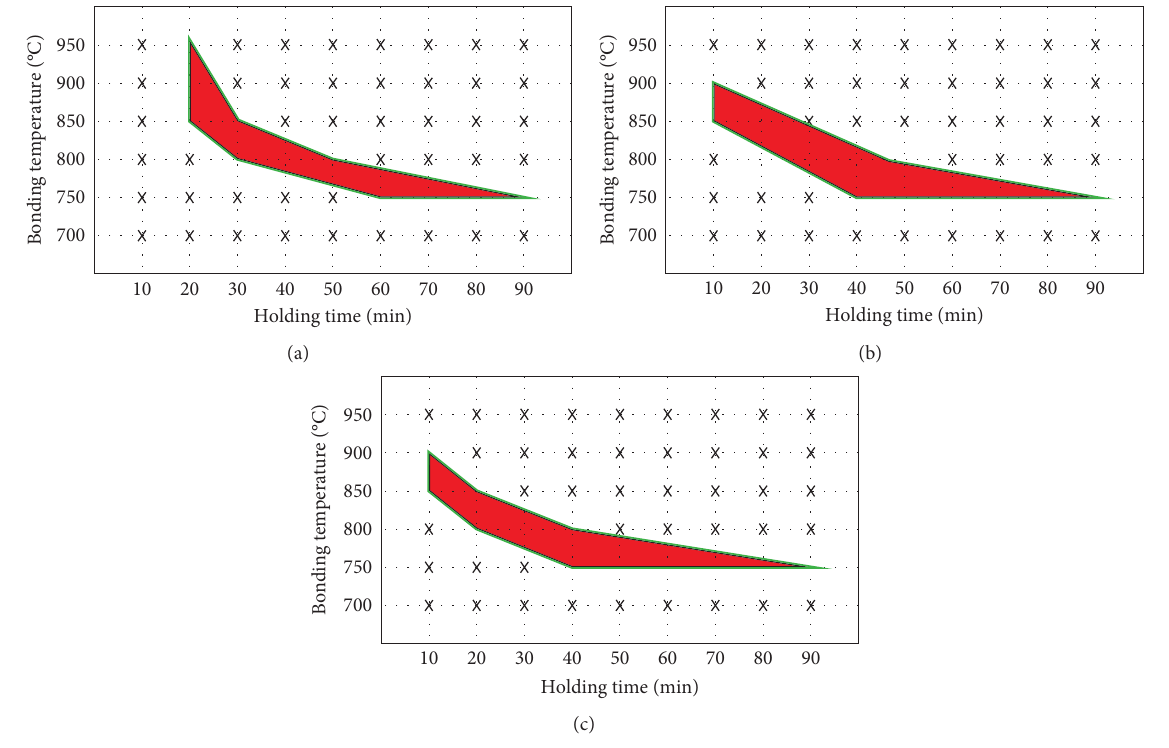
Figure 6: Temperature � time (T-t) diagrams. (a) 10 MPa. (b) 15MPa. (c) 20MPa.